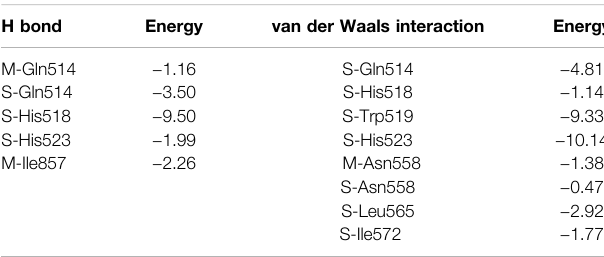
TABLE 8 | Energy of the main interactions between LOX-3residues and ligand 1s (M = main chain; S = side chain). H